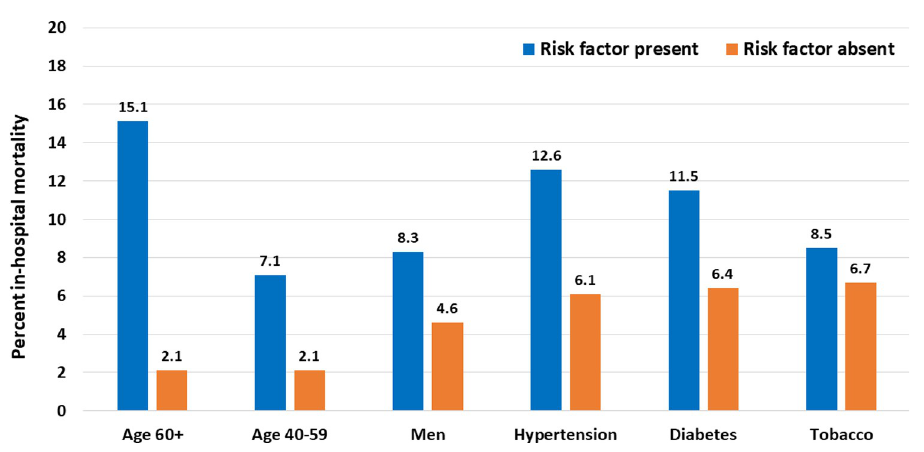
p-value calculated using χ 2 -square test for categorical variables and ANOVA for continuous variables.